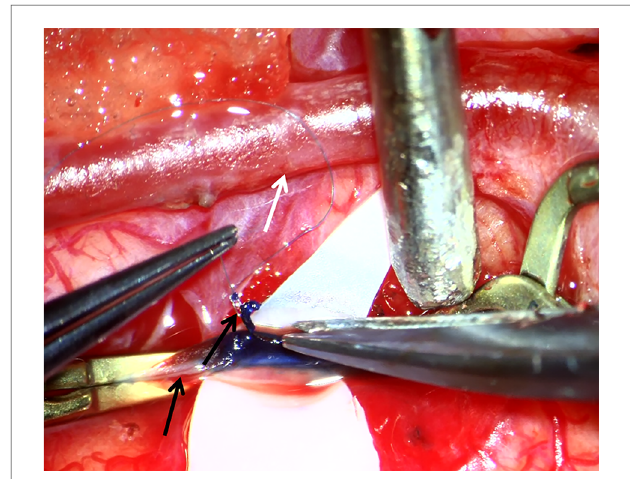
FIGURE 1 Surgical view of super fi cial temporal artery (STA) – middle cerebral artery (MCA) bypass. White arrow indicates STA. Lower black arrow indicates MCA (PSCA) and upper black arrow indicates tiny piece of PSCA which is collected as specimen for further histological and immunohistochemical